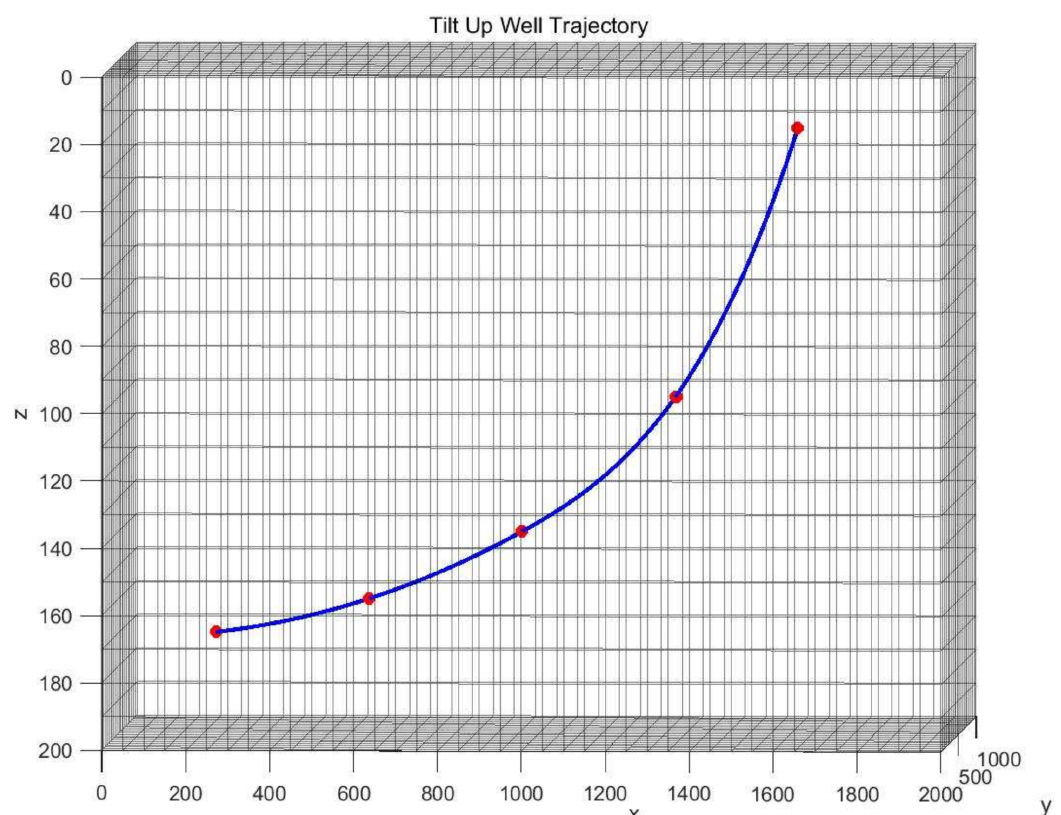
Figure 10. Tilt-up well trajectory with a depth difference of 120m from the well’s starting point.